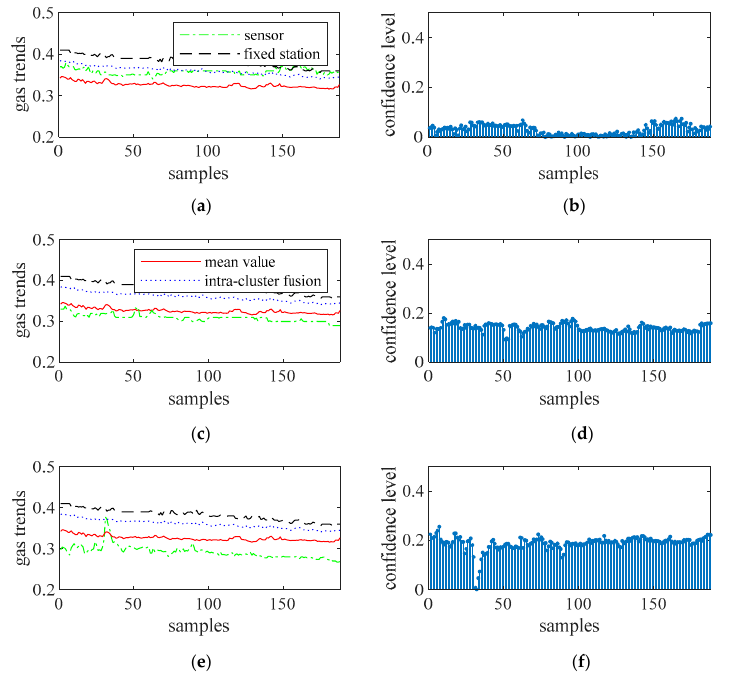
Figure 8. The measured values of sensors 1 to 3 and their confidence level. ( a ) gas sensor 1, ( b ) confidence level of gas sensor 1, ( c ) gas sensor 2, ( d ) confidence level of gas sensor 2, ( e ) gas sensor 3, ( f ) confidence level of gas sensor 3.